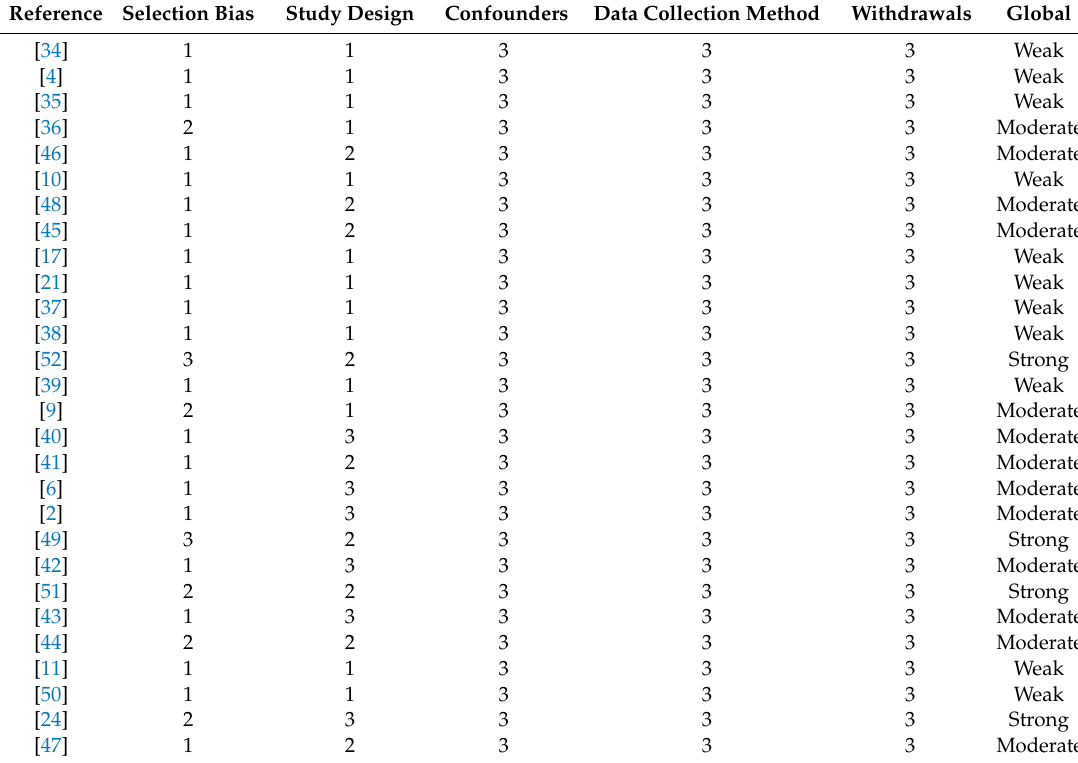
Table 2. Quality assessment of all included